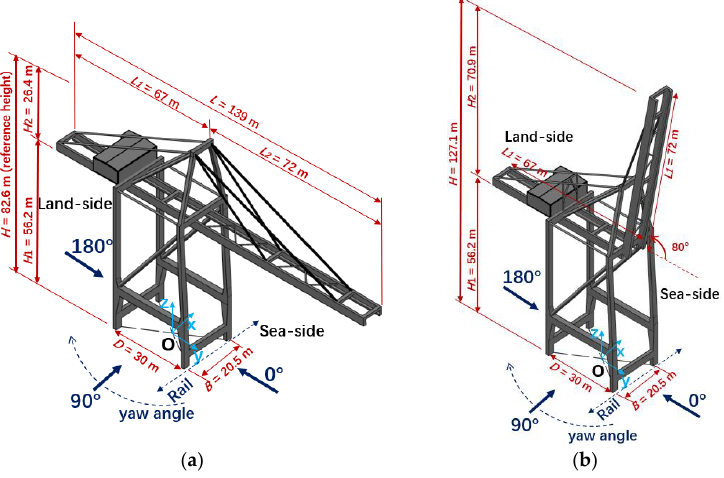
Figure 2. Test models: ( a ) boom-down state; and ( b ) boom-up state.